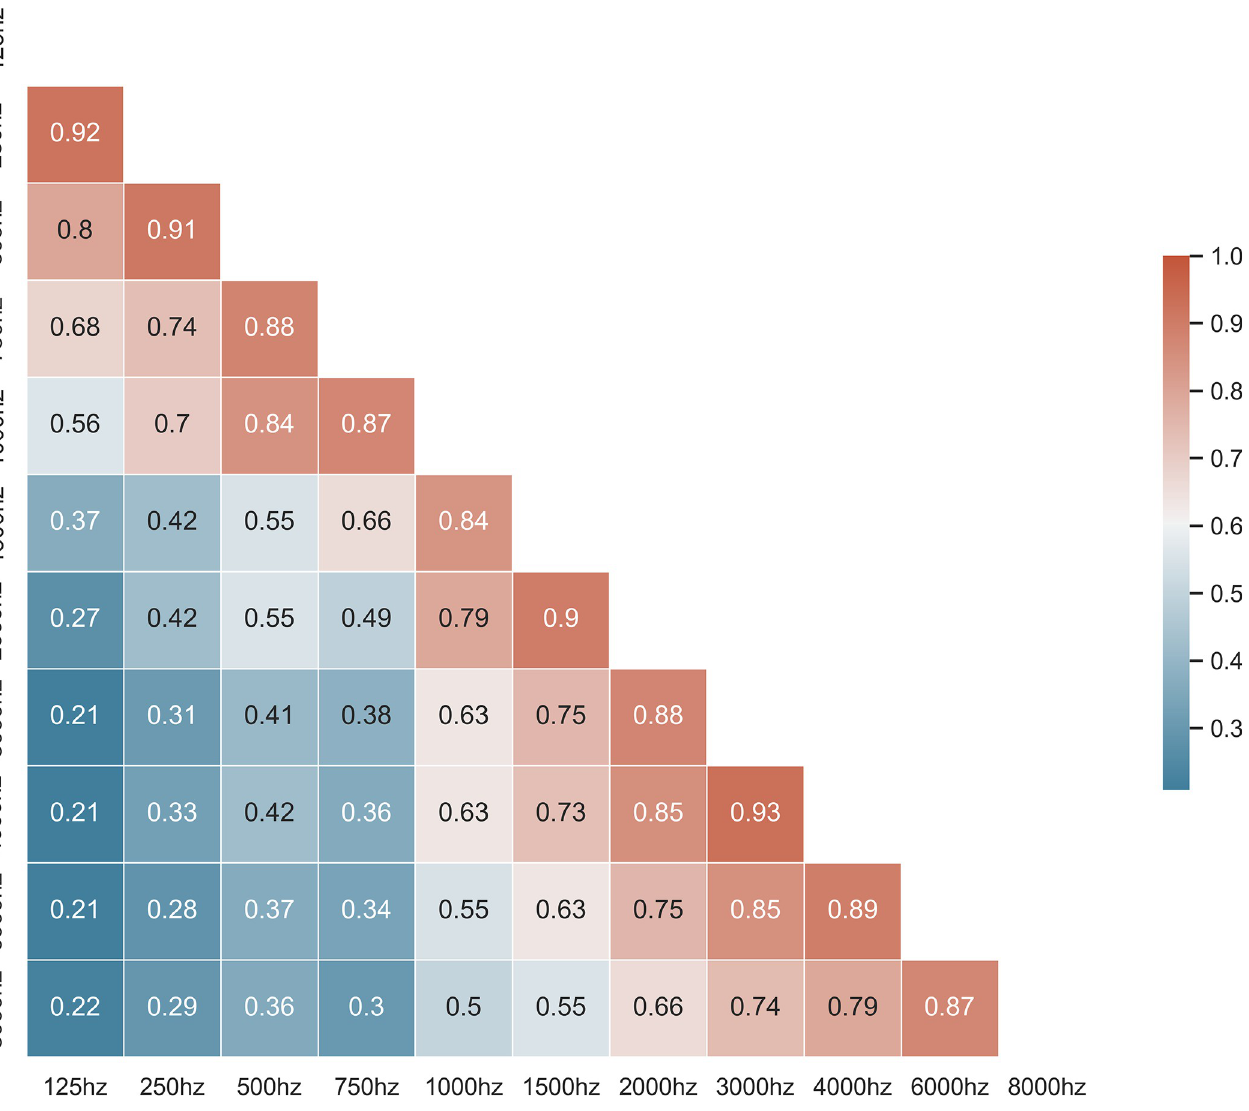
Fig 6. Audiometric correlation. Correlation matrix demonstrating the pairwise Pearson correlation coefficient between audiometric